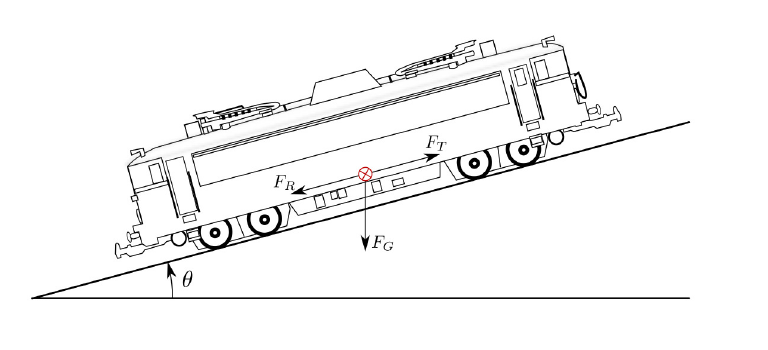
Figure 2. Train acting forces in uphill